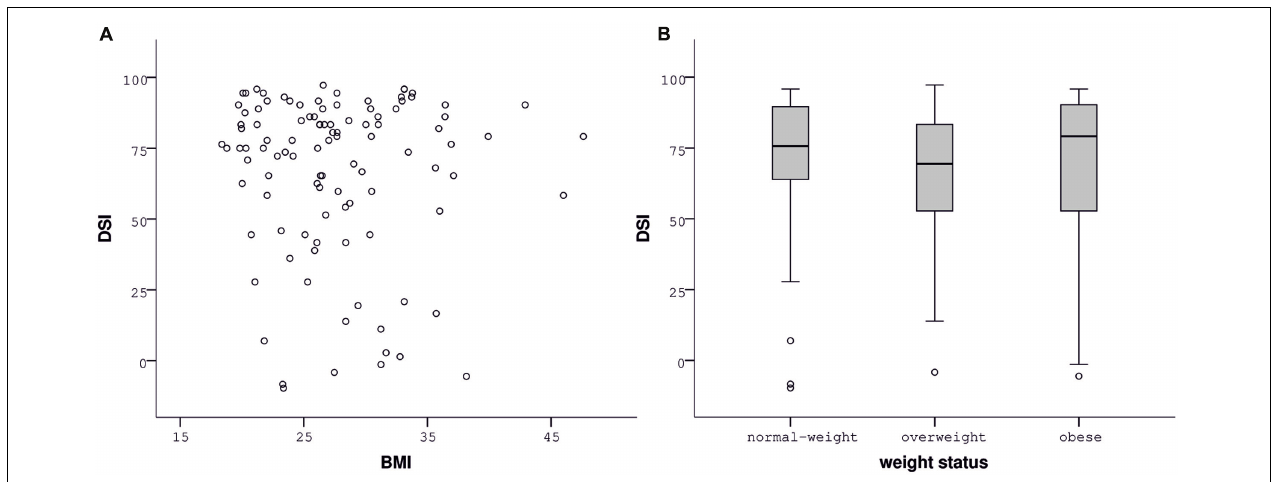
FIGURE 3 | Performance in the slips-of-action test depending on body mass index (BMI). The devaluation sensitivity index (DSI) did not correlate with BMI (A) or differ between normal-weight, overweight, and obese participants (B)